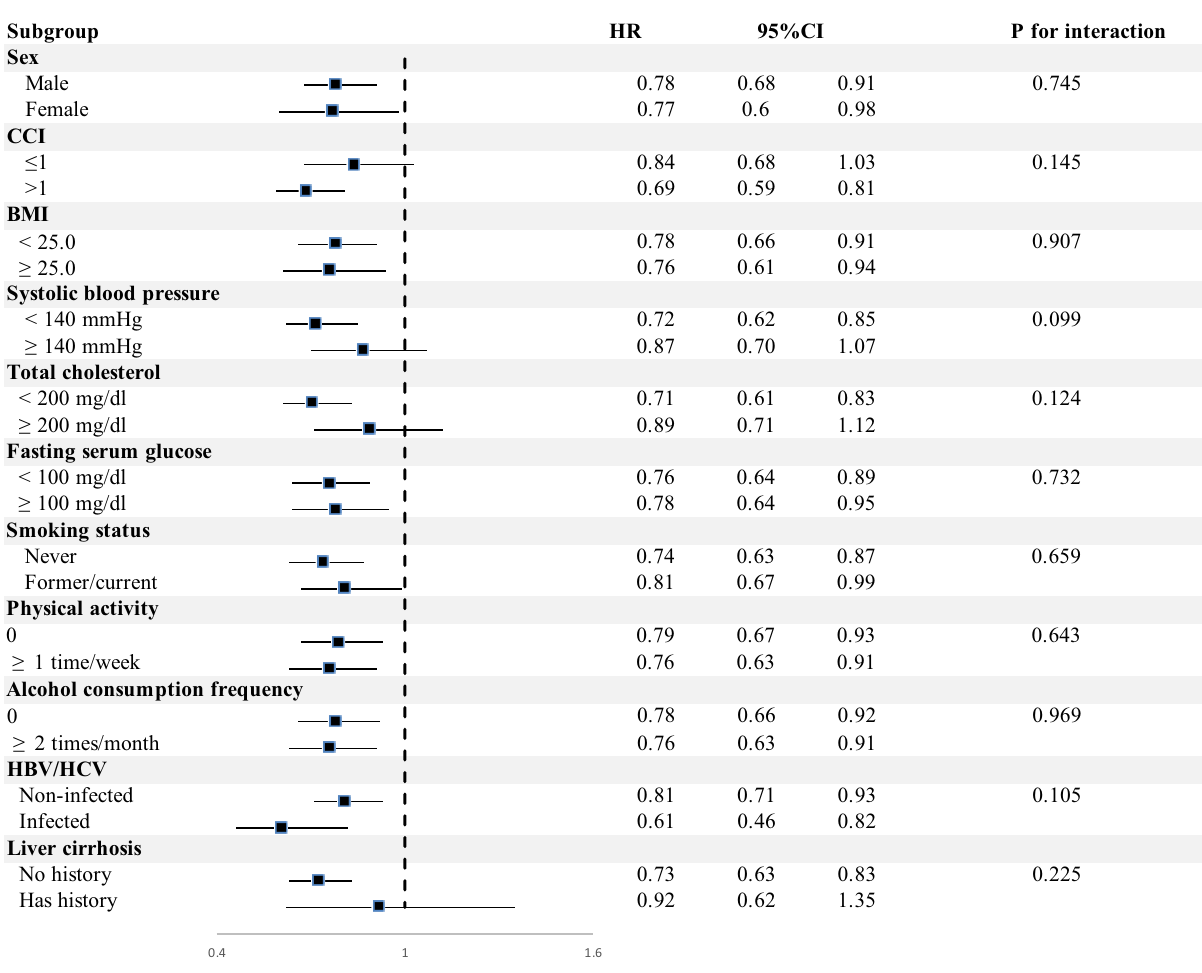
Figure 2. Stratified analysis on the association of the history of allergic diseases with the risk of liver cancer. Hazard ratio calculated by Cox proportional hazards regression analysis after adjustments for age, sex, body mass index, Charlson comorbidity index, household income, smoking, alcohol consumption, physical activity, systolic blood pressure, fasting serum glucose, total cholesterol, history of hepatitis B virus/hepatitis C virus infection and liver cirrhosis and the number of outpatient